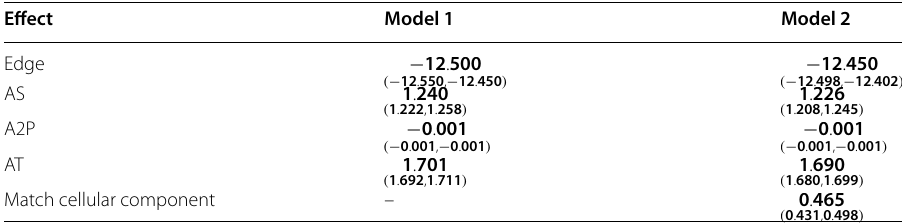
Parameter estimates that are statistically significant are shown in